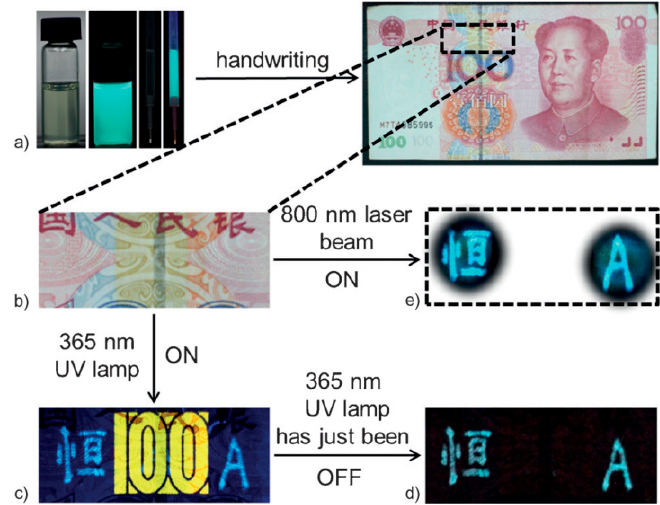
Figure 8. Triple emission mode of C-dots dispersed in a polyvinyl alcohol (PVA) matrix applied in a banknote ( a , b ), revealing fluorescence ( c ), room-temperature phosphorescence (RTP) ( d ) and up-